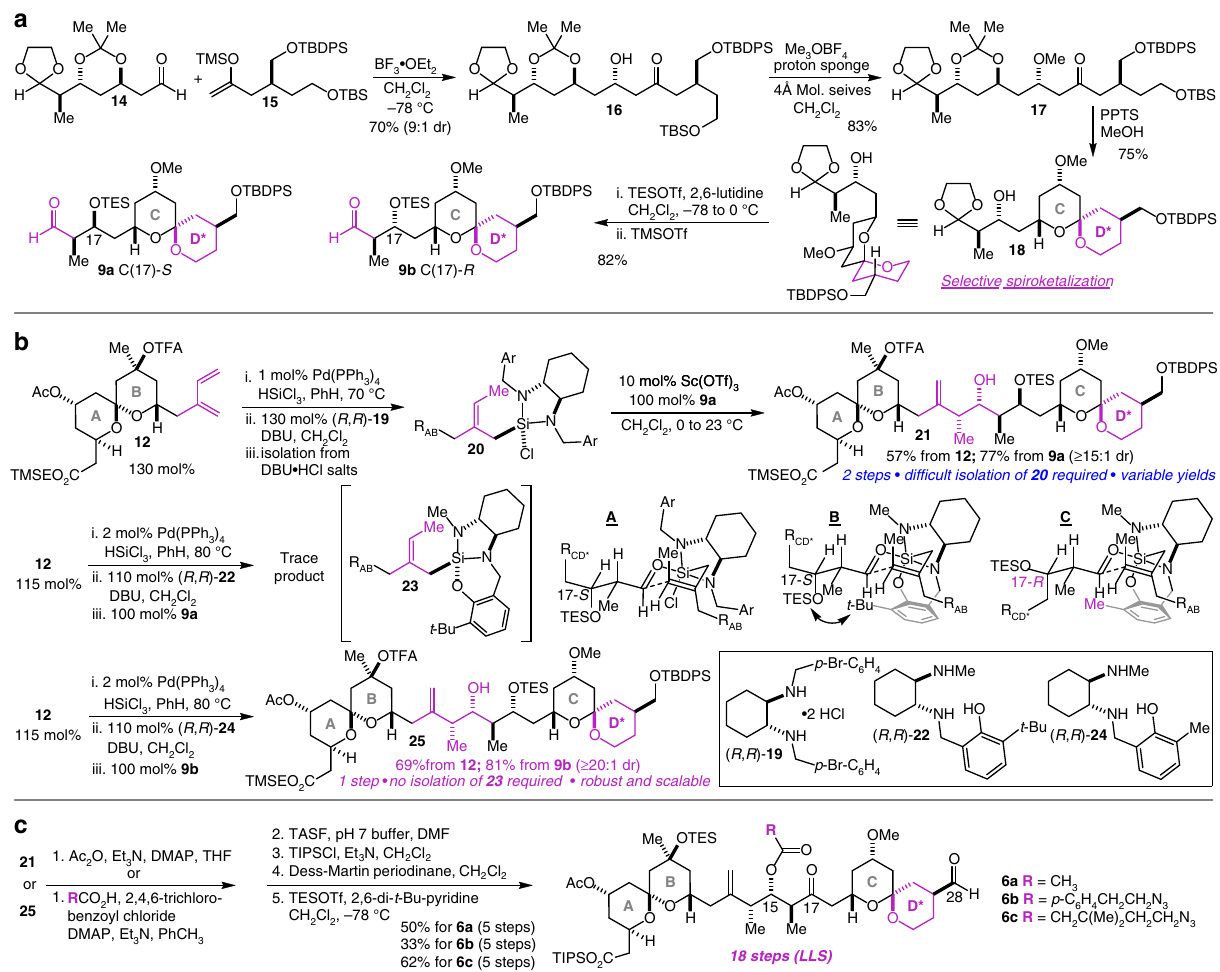
Fig. 3 An 18-step synthesis of the fully elaborated ABCD* fragment of the spongistatins. a The synthesis of the redesigned CD* spiroketals 9a and 9b entails as key steps a Mukaiyama aldol reaction and a diastereoselective spiroketalization reaction. b The direct complex fragment coupling syn -crotylation reaction to join AB spiroketal diene 12 with CD* spiroketal aldehyde 9b to produce 25 in a single step is robust and scalable and is the crucial innovation in the development of a highly step-economical and ef fi cient synthesis of the ABCD* fragment of the spongistatins. c Five straightforward steps convert 21 and 25 into the completed ABCD* fragment 6a and linker-equipped analogs 6b and 6c . DBU1,8-diazabicyclo[5.4.0]-undec-7-ene, DMAP4- dimethylaminopyridine, TASF tris(dimethylamino)sulfonium di fl